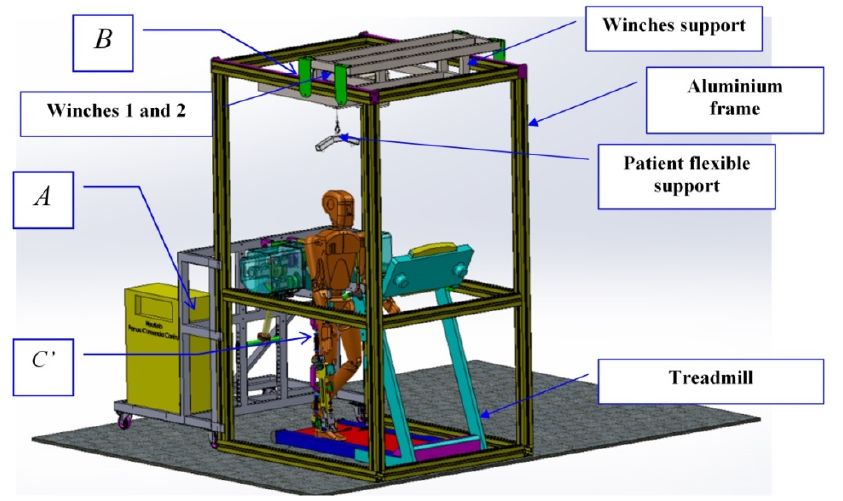
Figure 22. Robotic system virtual prototype with proper parts.